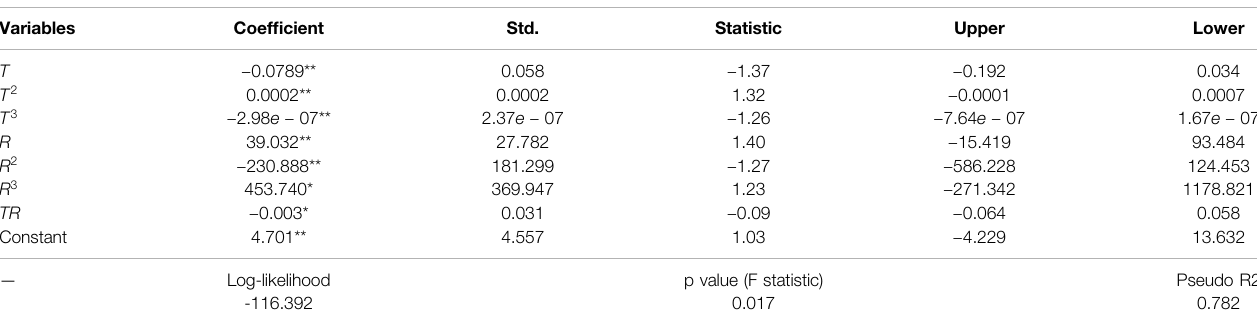
TABLE 6 | Estimation of the dose-response model.